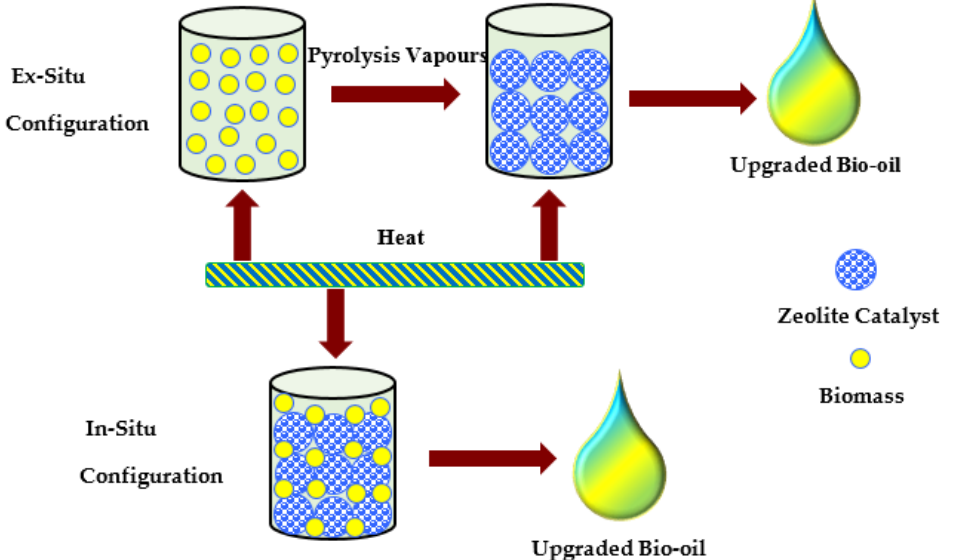
Figure 19. Configuration of ex situ and in situ catalytic fast pyrolysis.